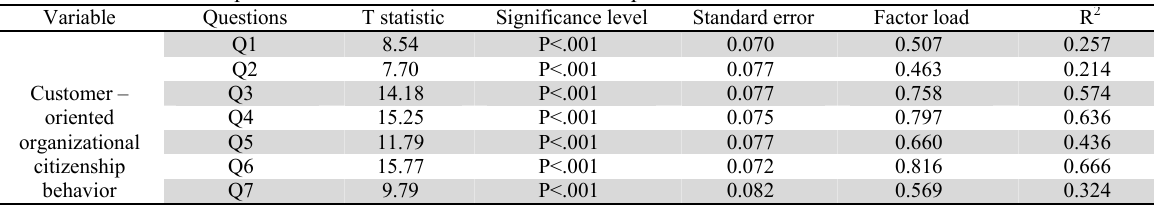
The results of CFA for question on Customer – oriented citizenship